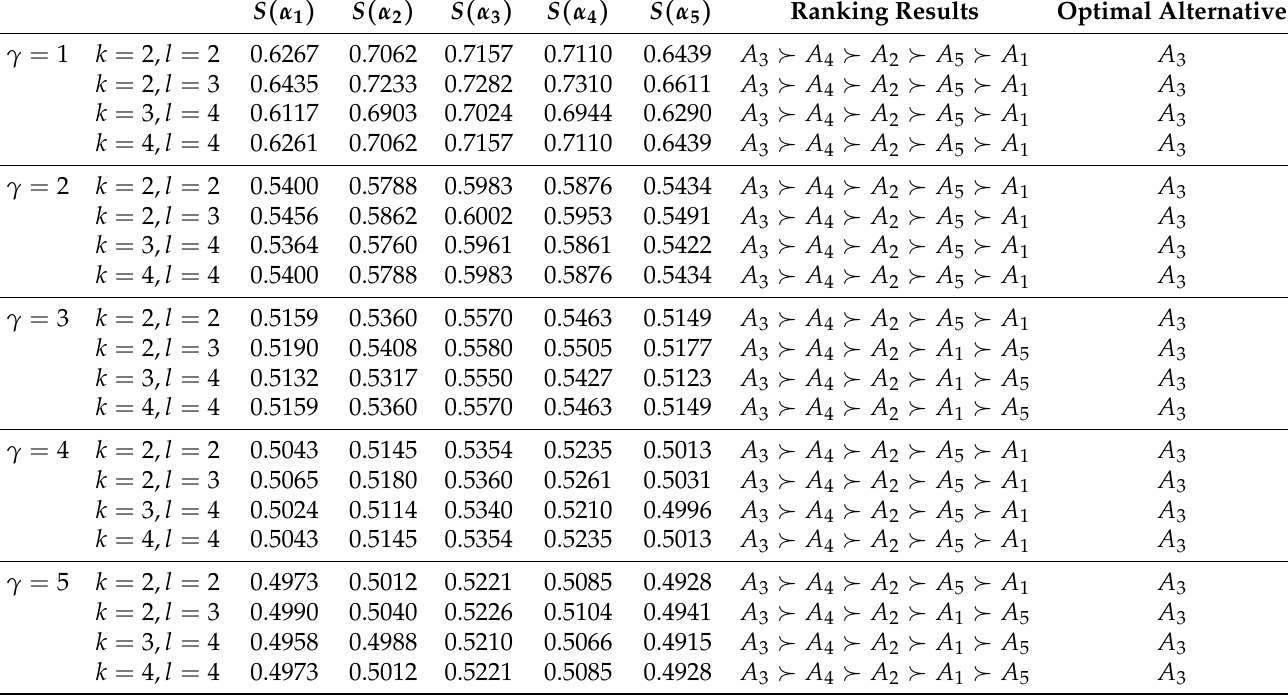
Table 8. Ranking results of the TSFWGDBM